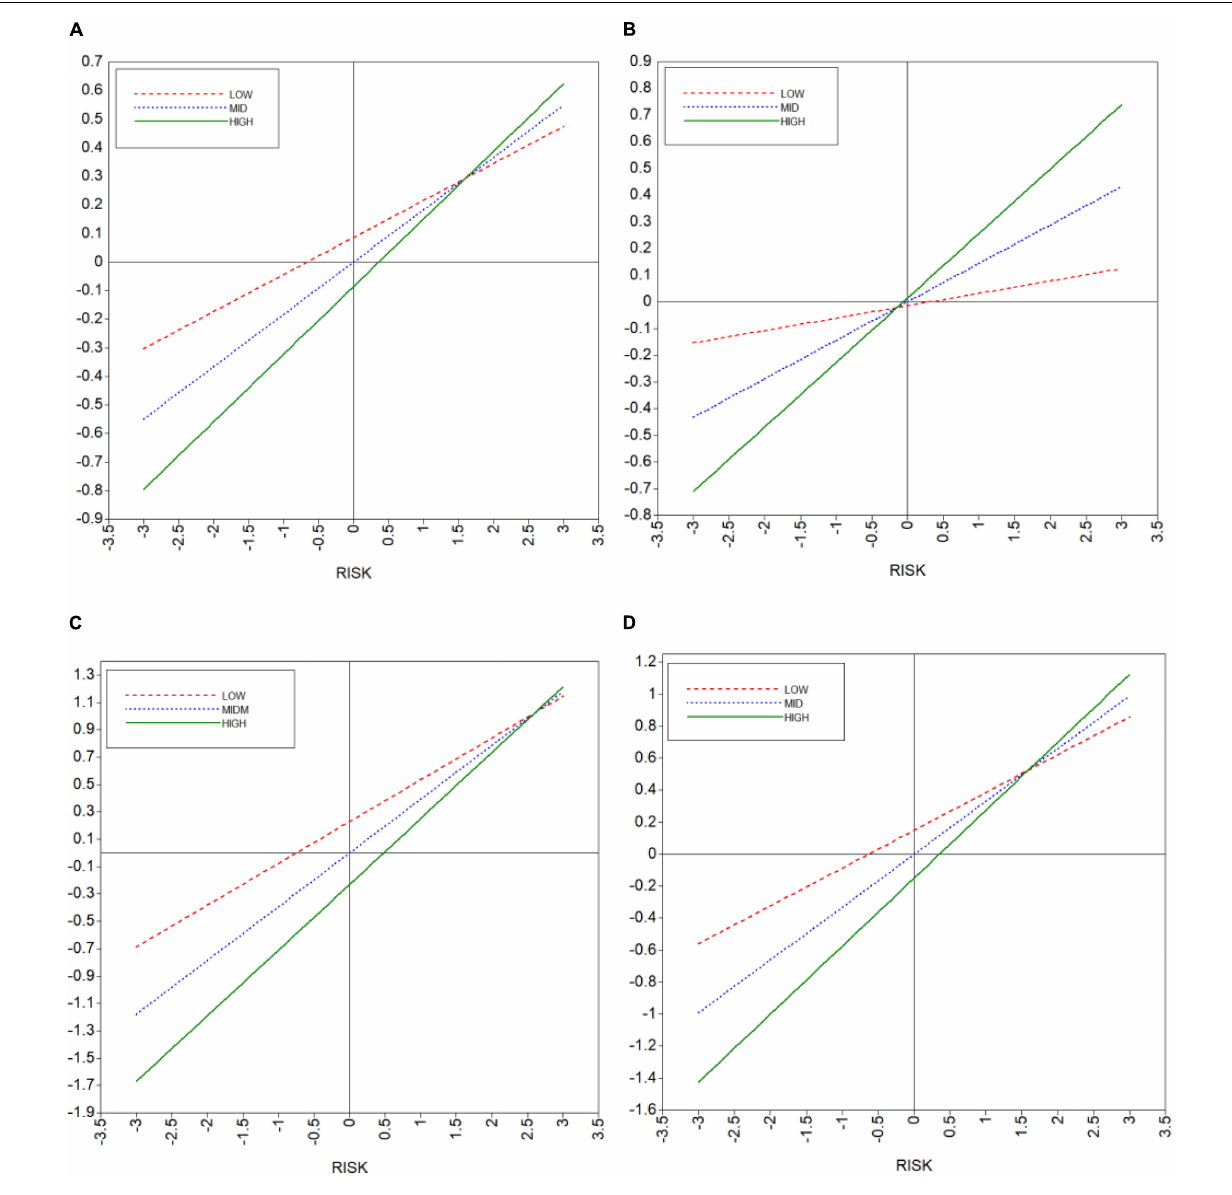
FIGURE 5 | Simple slope test. (A) Prfo. (B) P&L status. (C) Capital flow. (D) Staff